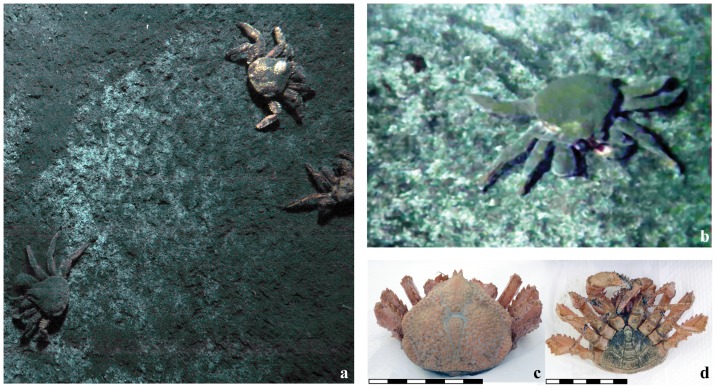
A lithodid crab (Paralomis diomedeae relative) commonly encountered at Md. 12.(a) Bird's eye view from a lander mounted still camera (ca. 40×50 cm), (b) close up with visible feeding tracks, (c) dorsal and (d) ventral view of the captured specimen. The scale bars represent 6 cm.